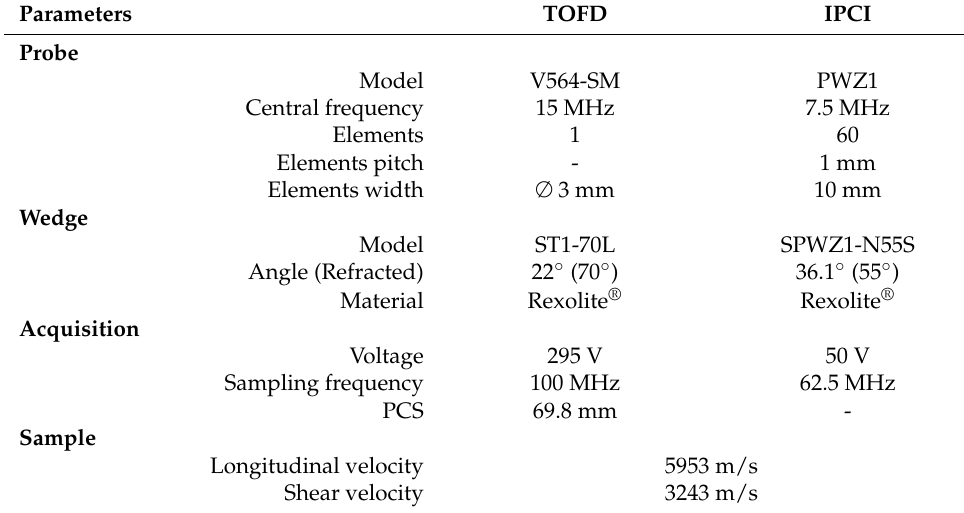
Table 2. Experiment